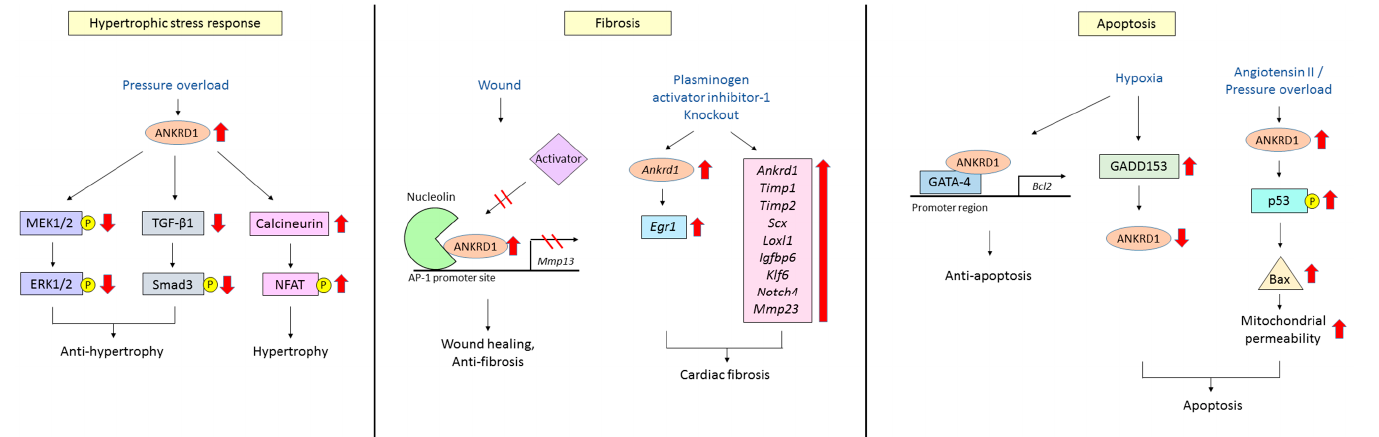
Figure 3. Schematic diagram showing the pathological cardiac functions of ANKRD1 in relation to hypertrophy, fibrosis and apoptosis. Hypertrophic stress response : Pressure overload rapidly increases the expression of cardiac ANKRD1 and inhibits the ERK and TGF- β /Smad pathways, leading to the attenuation of hypertrophy. This is thought to be an adaptive and protective response. Conversely, increase in ANKRD1 also exacerbates pathological cardiac remodeling through activation of the calcineurin/NFAT pathway, a signaling pathway known to have an important role in cardiac hypertrophy. Hence, the role of ANKRD1 in cardiac hypertrophy is still controversial; Fibrosis : Nuclear ANKRD1 interacts with nucleolin and hinders the binding of positive transcriptional activators to the AP-1 promoter site, thus inhibiting transcription of the Mmp13 gene. This limits the expression of MMP13 to within appropriate physiological levels to enable successful tissue repair. On the other hand, expression of Ankrd1 is increased in plasminogen activator inhibitor-1 knockout mouse. This in turn induces the elevation of Egr1 which is associated with cardiac fibrosis. In addition, the concomitant upregulation of several genes involved in pro-fibrotic responses including Ankrd1 also leads to the development of cardiac fibrosis; Apoptosis : Hypoxia-induced up-regulation of GADD153 leads to a decrease in ANKRD1 expression which has been shown to cause apoptotic cell death. ANKRD1 also acts as a co-factor of the transcription factor GATA-4 to induce anti-apoptotic Bcl2 gene expression. These results support the role of ANKRD1 as an anti-apoptotic factor. Conversely, it has also been reported in hearts stimulated with either angiotensin II or challenged by pressure overload that overexpression of ANKRD1 led to an increase in cardiomyocyte apoptosis, indicating that ANKRD1 could also have pro-apoptotic properties. Hence, ANKRD1 seems to be able to either enhance or inhibit apoptosis under different conditions, depending on the type of pathological stimuli. Black arrows indicate the downstream effect. Red arrows indicate an increase or decrease in expression or phosphorylation of the protein. Inhibition of downstream effect is indicated by two red lines drawn across a black arrow. Yellow-circled P indicates phosphorylation. ANKRD1, ankyrin repeat domain 1; AP-1, activator protein 1; Bcl2 , B-cell lymphoma 2; Egr1 , early growth response gene 1; ERK, extracellular signal–regulated kinase; GADD153, growth arrest and DNA damage 153; GATA-4, GATA binding protein 4; Igfbp6, insulin-like growth factor binding protein 6; Klf6, kruppel like factor 6; Loxl1, lysyl oxidase like 1; MEK, mitogen-activated protein kinase kinase; Mmp13, matrix metalloproteinase 13; NFAT, nuclear factor of activated T-cells; Scx, scleraxis basic helix-loop-helix transcription factor; Smad, mothers against decapentaplegic homolog; TGF- β , transforming growth factor β ; Timp2, tissue inhibitor of metalloproteinase 2.